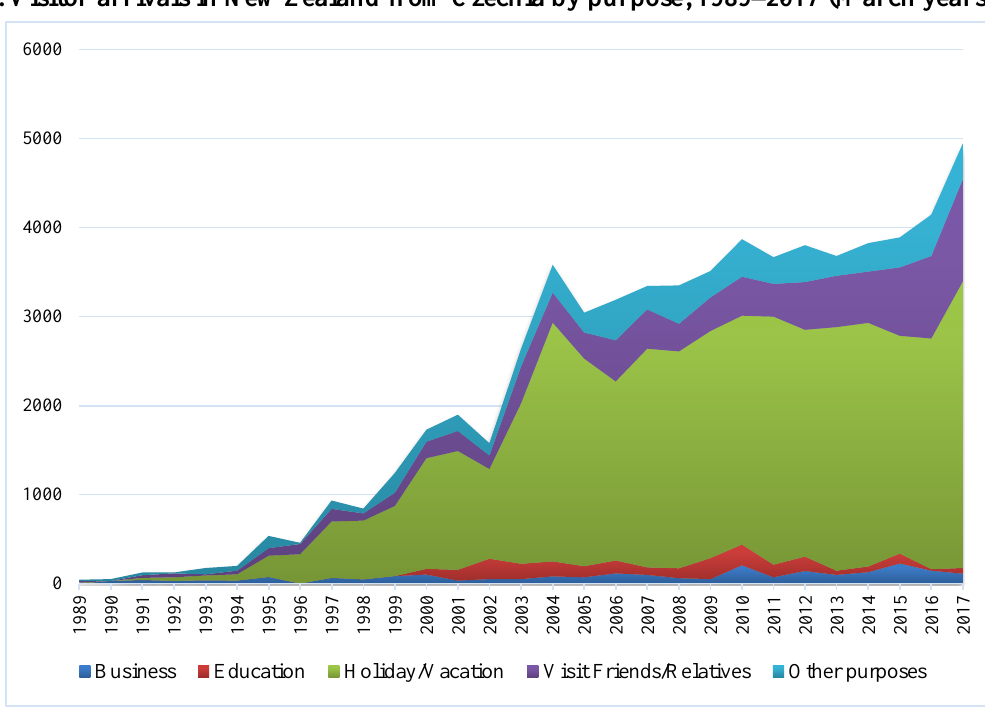
Figure 1. Visitor arrivals in New Zealand from Czechia by purpose, 1989–2017 (March years)